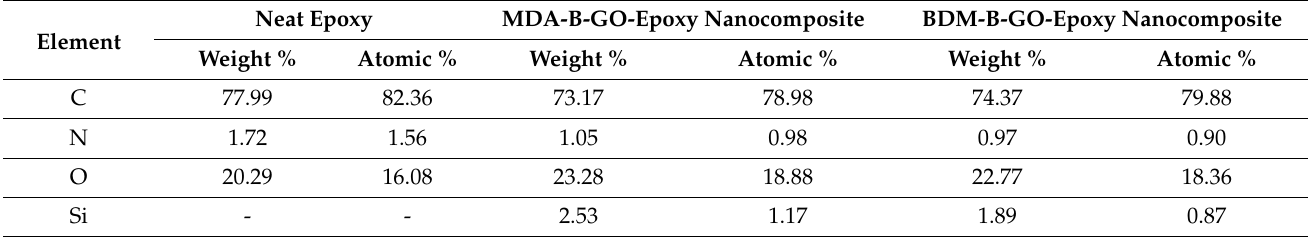
Figure 6. EDX spectra of ( a ) neat epoxy ( b ) 5% MDA-B-GO nanocomposite and ( c ) 5% BDM-B-GO nanocomposite. Table 4. Percentages of elements in neat epoxy and its